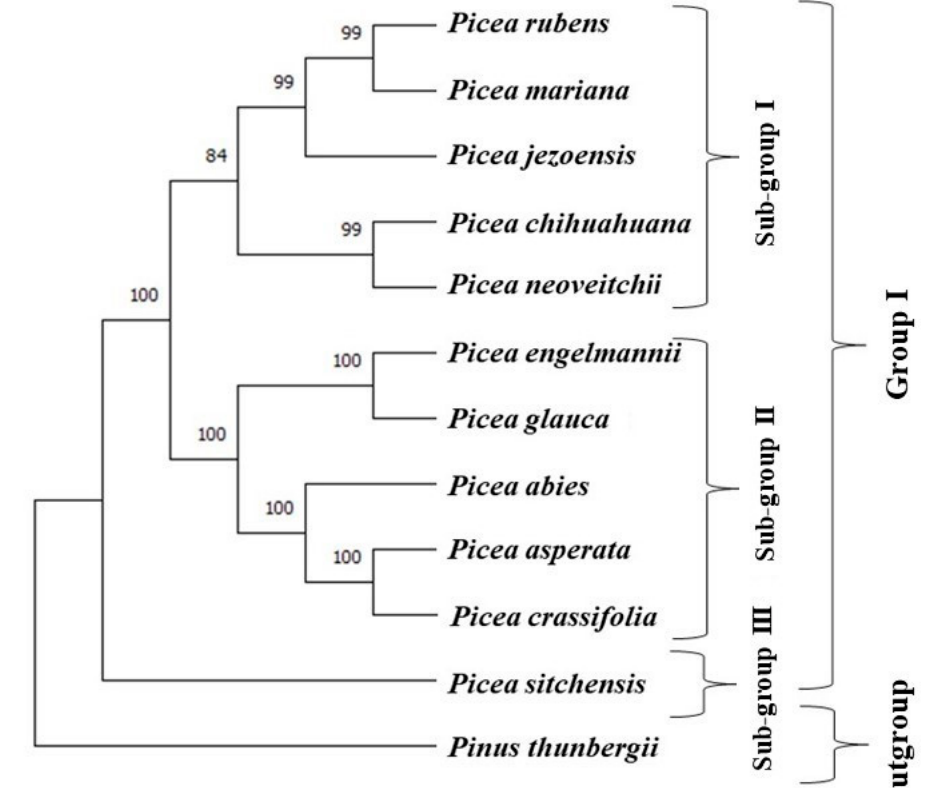
Figure 4. A rooted neighbor-joining phylogenetic tree of 11 Picea species using Pinus thunbergii as the outgroup, based on their whole chloroplast genome sequences. The numbers on the nodes are the percent support from 1000 bootstraps.